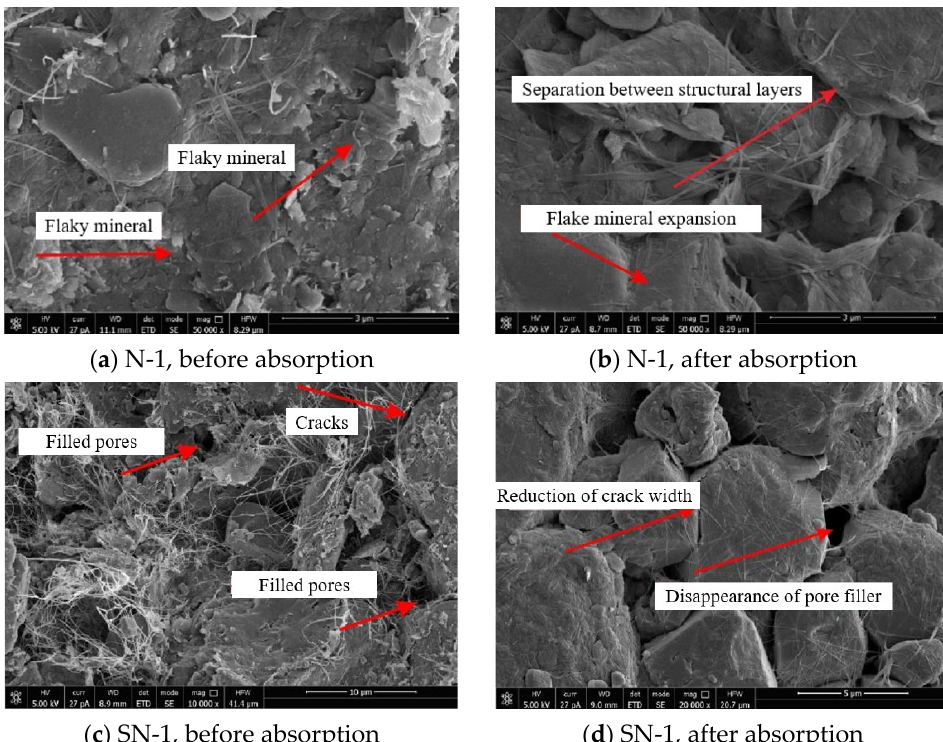
Figure 3. SEM of mudstone before and after water absorption at high magnification